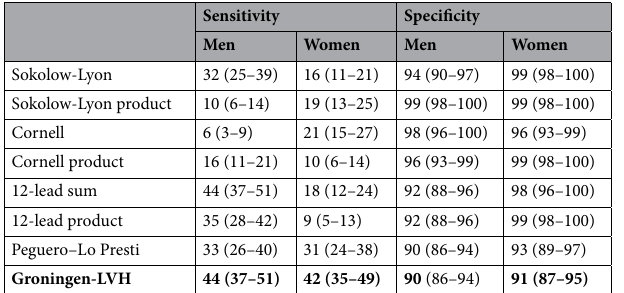
Table 2. Sensitivity and specificity of ECG-LVH criteria by sex in complete cohort. LVH left ventricular